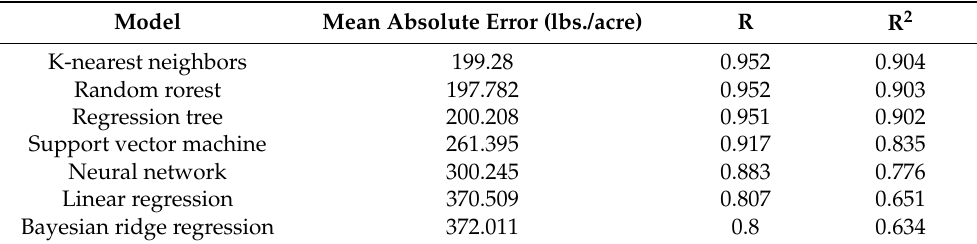
Figure 7 . Results from Wrapper feature selection operator. The results from linear regression and Bayesian ridge regression were much lower than the other models, so their results are not shown here. The results are shown explicitly in Table 8. Table 8. Results from Wrapper feature selection operator. The average scores from using the features number of days since the sown date, total rainfall, day length, and the Julian day.